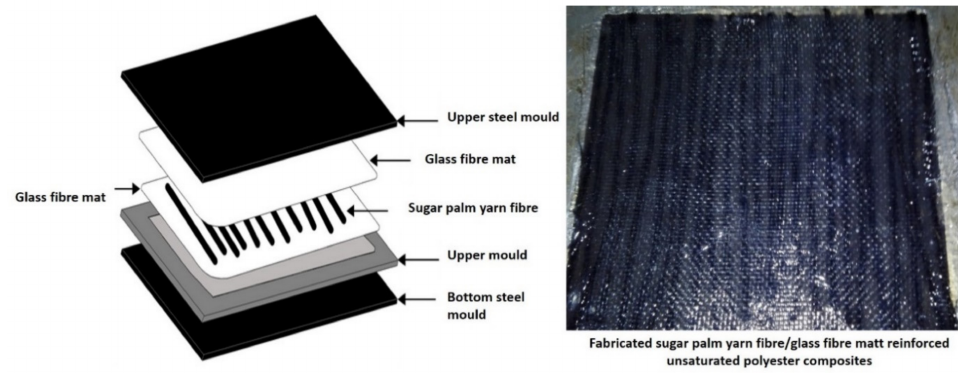
Figure 8. Schematic diagram of the hybridization layer of sugar palm yarn fibers with glass fiber mat-reinforced unsaturated polyester composite. Reproduced from ref.